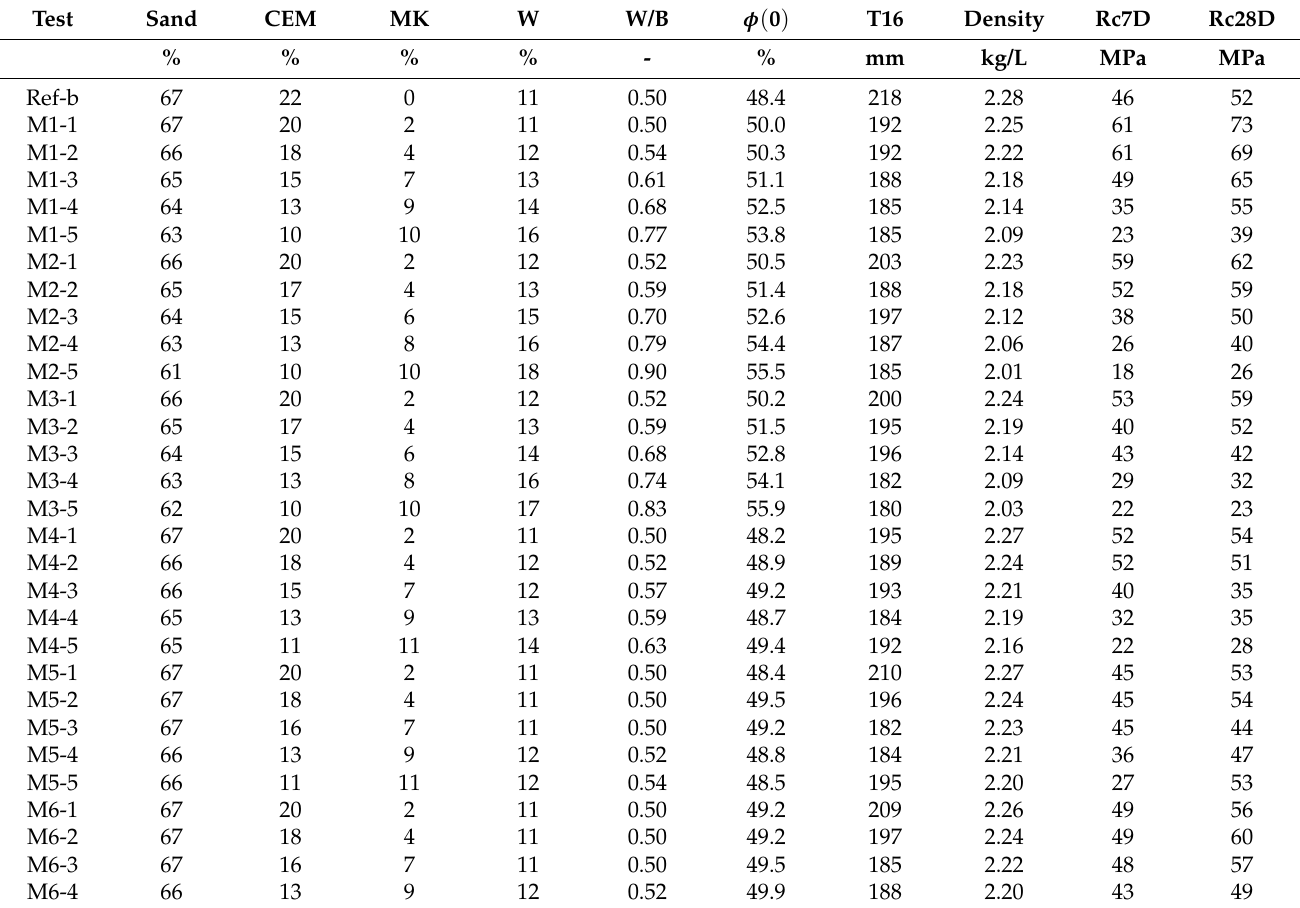
Table 7. Formulations of the mortars prepared with different contents of sand, cement (CEM), metakaolin (MK) and water (W) given as mass percentage, with the corresponding slump tests after 16 shocks (T16), the medium density and compressive strength at 7 and 28 days (Rc7D and Rc28D). The initial porosity calculated φ ( 0 ) is given for each